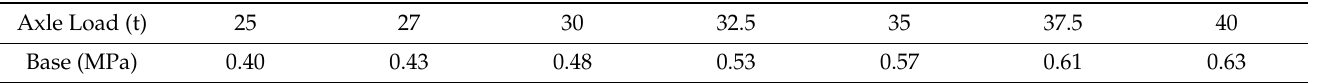
Figure 24. Diagram of calculation of longitudinal tensile stress of base (25 t). Table 8. Maximum Longitudinal Tensile Stress.